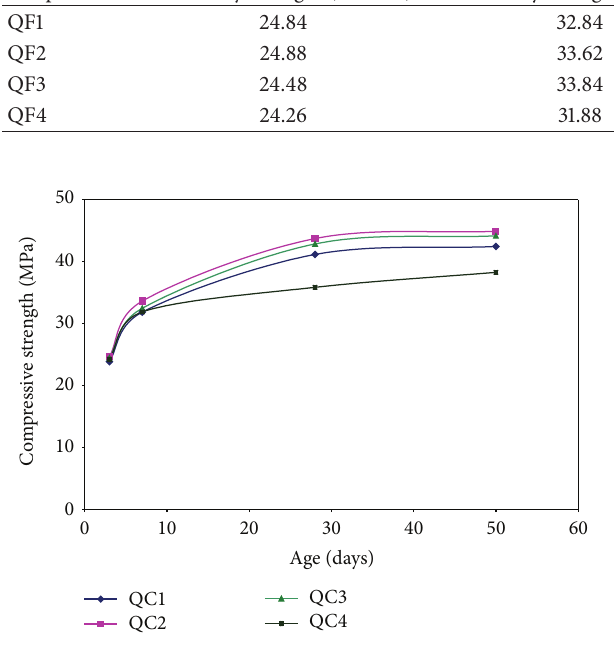
Figure 3: Compressive strength test results for QC series.